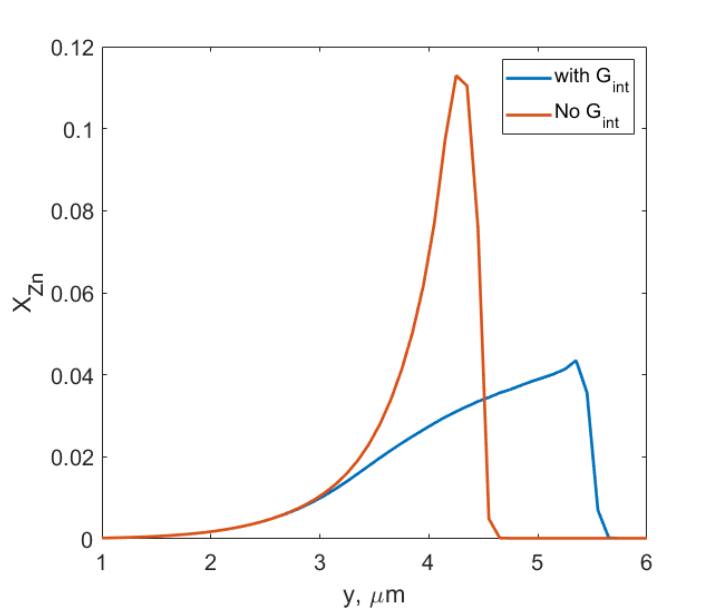
Figure 3. X Zn along the surface referring to Figure 2 at x = 10 µ m, with and without G int after 3 h. Due to grain boundary migration, a steep but continuously increasing profile of X Zn is left behind the growing front, Figure 3. On a closer look at the profile, it was noted that the effect of the grain boundary curvature was only active at the beginning, and the effect of G int was relatively low during that time. This is evident from Figure 3 where the red curve corresponding to G int = 0 and the blue curve with a non-zero G int overlap with each other till 3 µ m. After that, the X Zn achieves a sufficiently high value which generates a significant concentration gradient across the interface. As a result, the interaction term becomes active and aids in pushing the grain boundary to 5.6 µ m (blue curve). As per the experiments, the surface concentration of Zn should reach around 11 wt% after 16.5 h (see Figure 17 in Ref. [23]) which corresponds to X Zn = 0.095. Compared to the simulation results, X Zn reaches 0.077 after 16 h, Figure 4, which is in reasonable agreement with the experimental measurement.